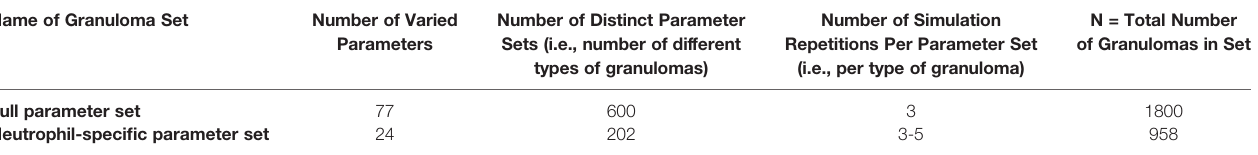
TABLE 2 | Overview of granuloma sets generated in the calibration process. Name of Granuloma Set Number of Varied